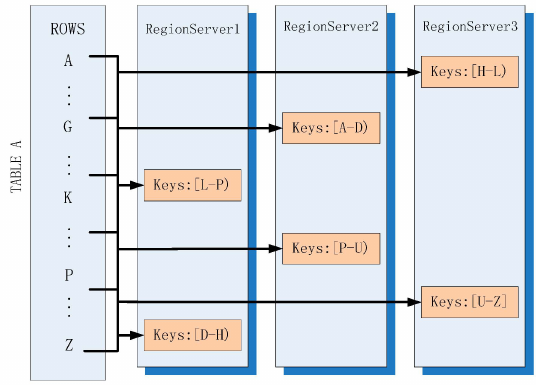
Figure 2. Horizontal partitioning in